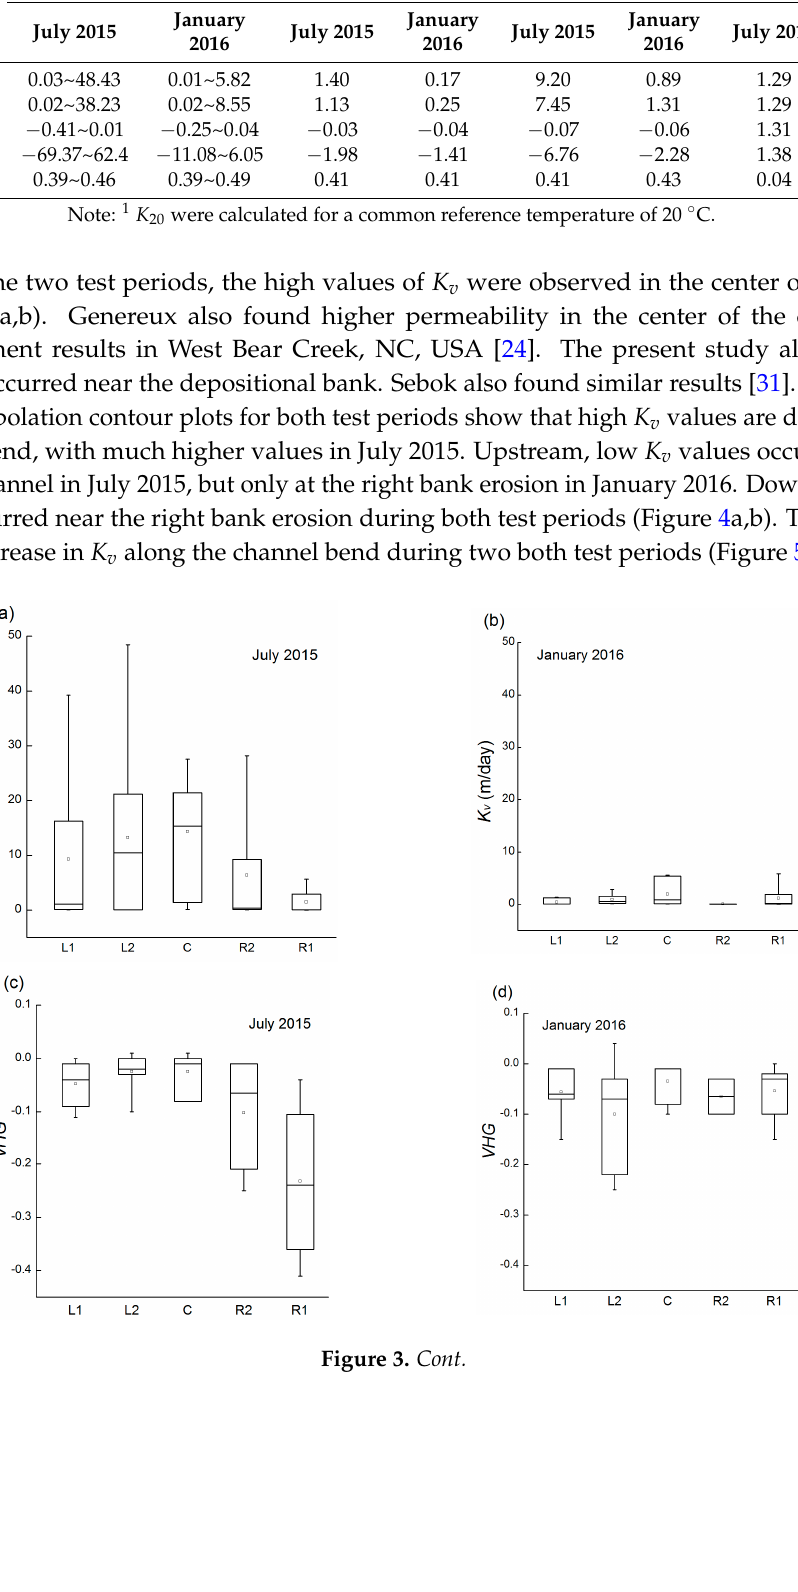
Table 2. Statistics of K v , K 20 , VHG , DF , and porosity ( φ ) during July 2015 and January